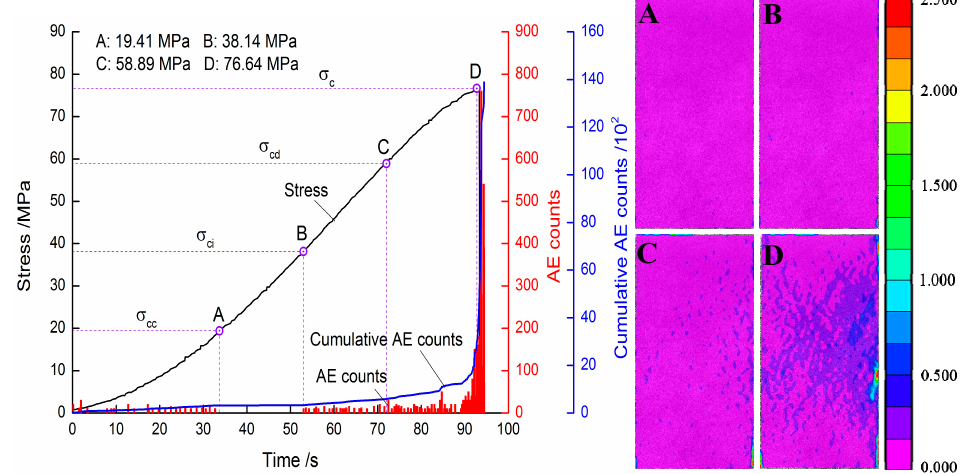
Figure 8. Acoustic emission (AE) behavior and strain fields of intact specimen Int-1.